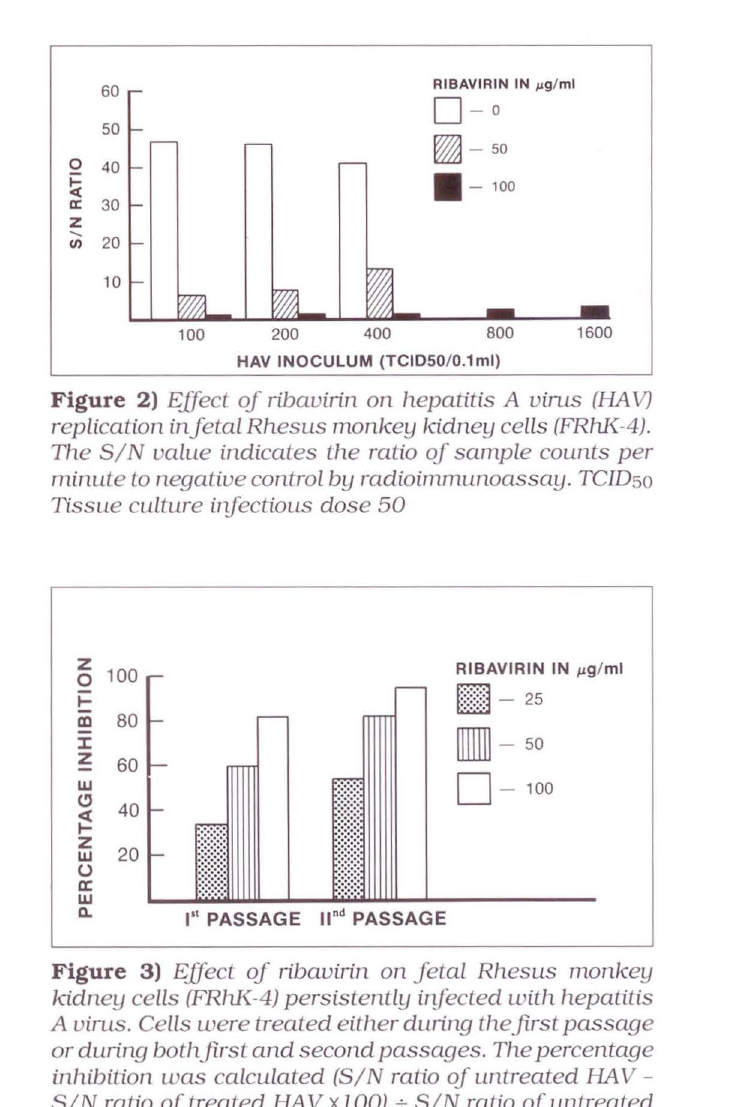
Figure 3) Effect of ribavirin on fetal Rhesus monkey kidney cells (FRhK-4) persistently infected with